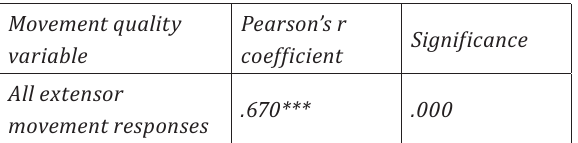
Table 12. Pearson’s r correlations in the group of all mothers (N = 53) between the “chiaroscuro” variable and all extensor movement responses